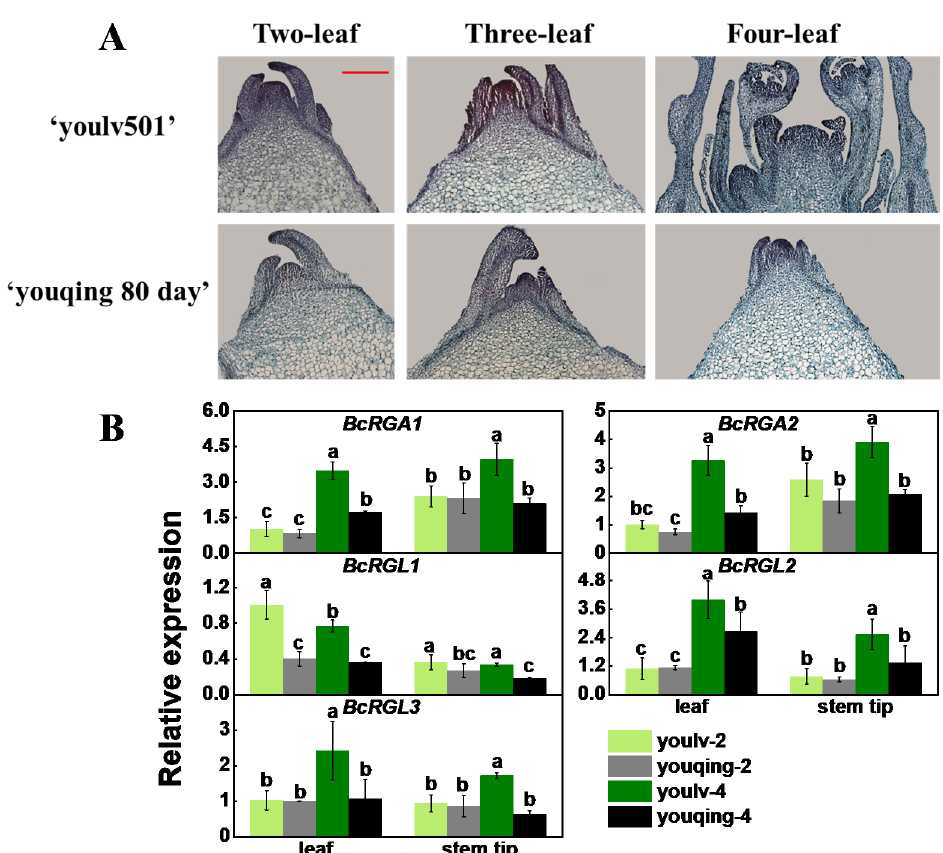
Figure 5. Expression analysis of DELLA genes in the ‘youlv501’ and ‘youqing 80 day’ varieties of flowering Chinese cabbage. ( A ) Stem tip longitudinal structures of ‘youlv501’ and ‘youqing 80 day’ flowering Chinese Cabbage. All the pictures were taken under a 10 × microscope, and the scale was unified at 200 μm. ( B ) Among them, youlv-2 and youqing-2 represent the two-true-leaf stage of ‘youlv501’ and ‘youqing 80 day’ respectively. youlv-4, and youqing-4 represent the four-true-leaf stage of ‘youlv501’ and ‘youqing 80 day’, respectively. The data represents an average of three replicates ± standard error. Values followed by the same letter are not significantly different using Duncan’s test at p < 0.05.